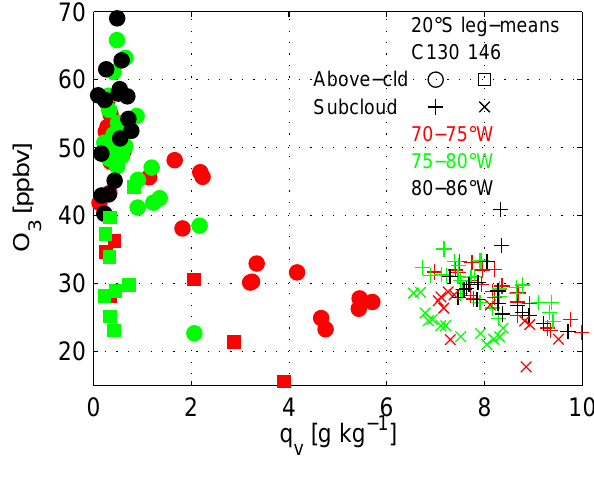
Fig. 7. Scatter plot of ozone concentration versus specific humidity from aircraft measurement, colour-coded for longitudinal zones and symbolized for aircraft platform and location below or above cloud, as detailed in the figure legend.